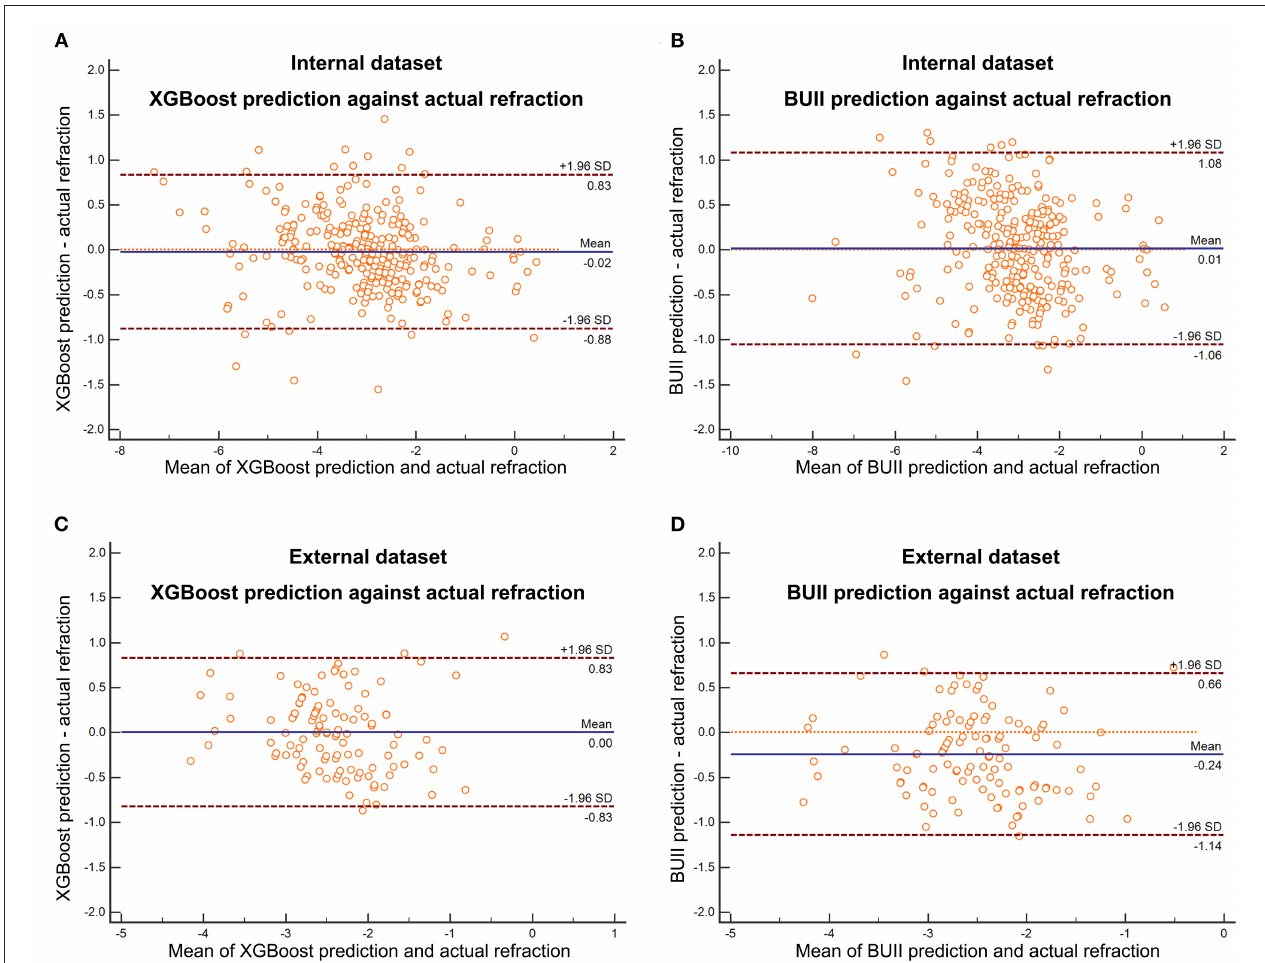
FIGURE 2 | The Bland-Altman plots with actual postoperative refraction against the XGBoost prediction in the internal (A) and external (C) test dataset or Barrett Universal II formula (BUII) prediction in the internal (B) and external (D) test dataset.